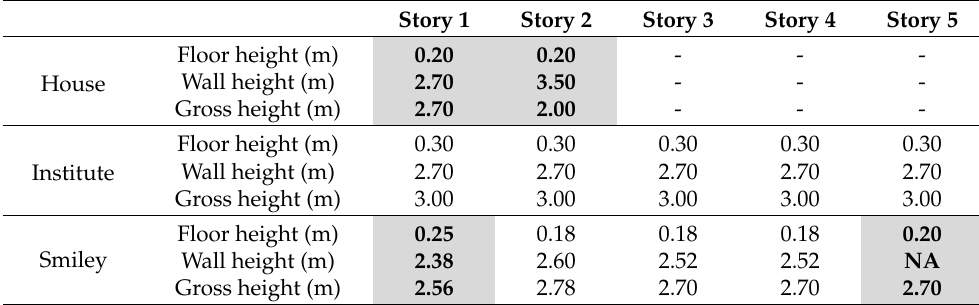
Table 11. Building story height acquired from two sources.